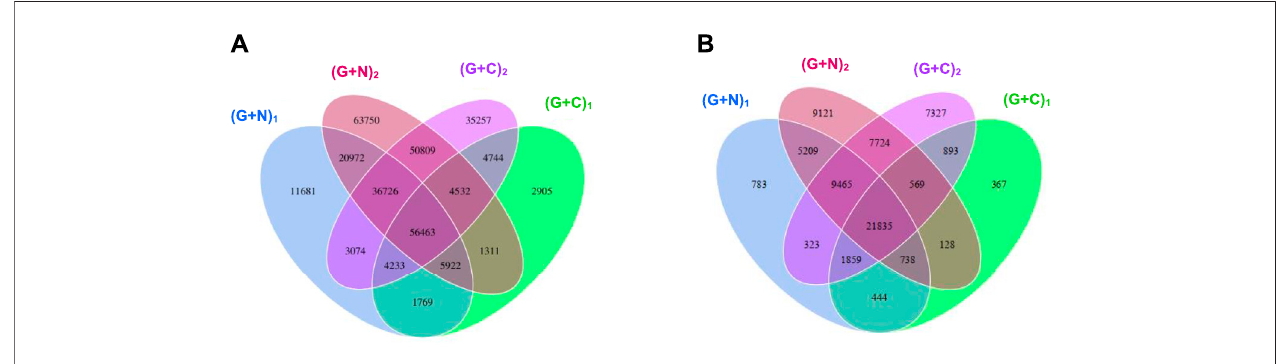
FIGURE9| Venndiagramsofgenenumberof (A) thetotalgenesand (B) thegenesin Clostridium genuslevel.Theoverlappartsrepresentthenumberofcommon genes between/among samples (groups); the other parts represent the number of special genes of samples (groups). “ (G + N) 1 ” represents when glucose was totally consumed using glucose as substrate and “ (G + N) 2 ” represents at the end of the incubation after CO was added. “ (G + C) 1 ” represents when glucose was totally consumed and “ (G + C) 2 ” represents at the end of the incubation in glucose and CO